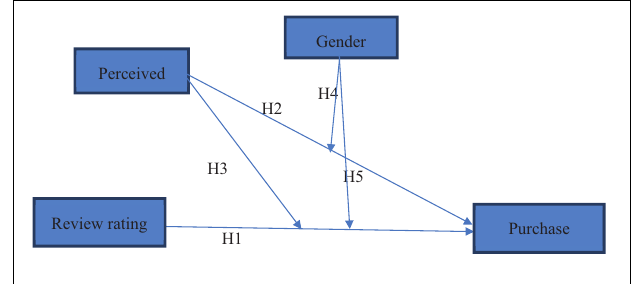
FIGURE 1 | Conceptual framework.